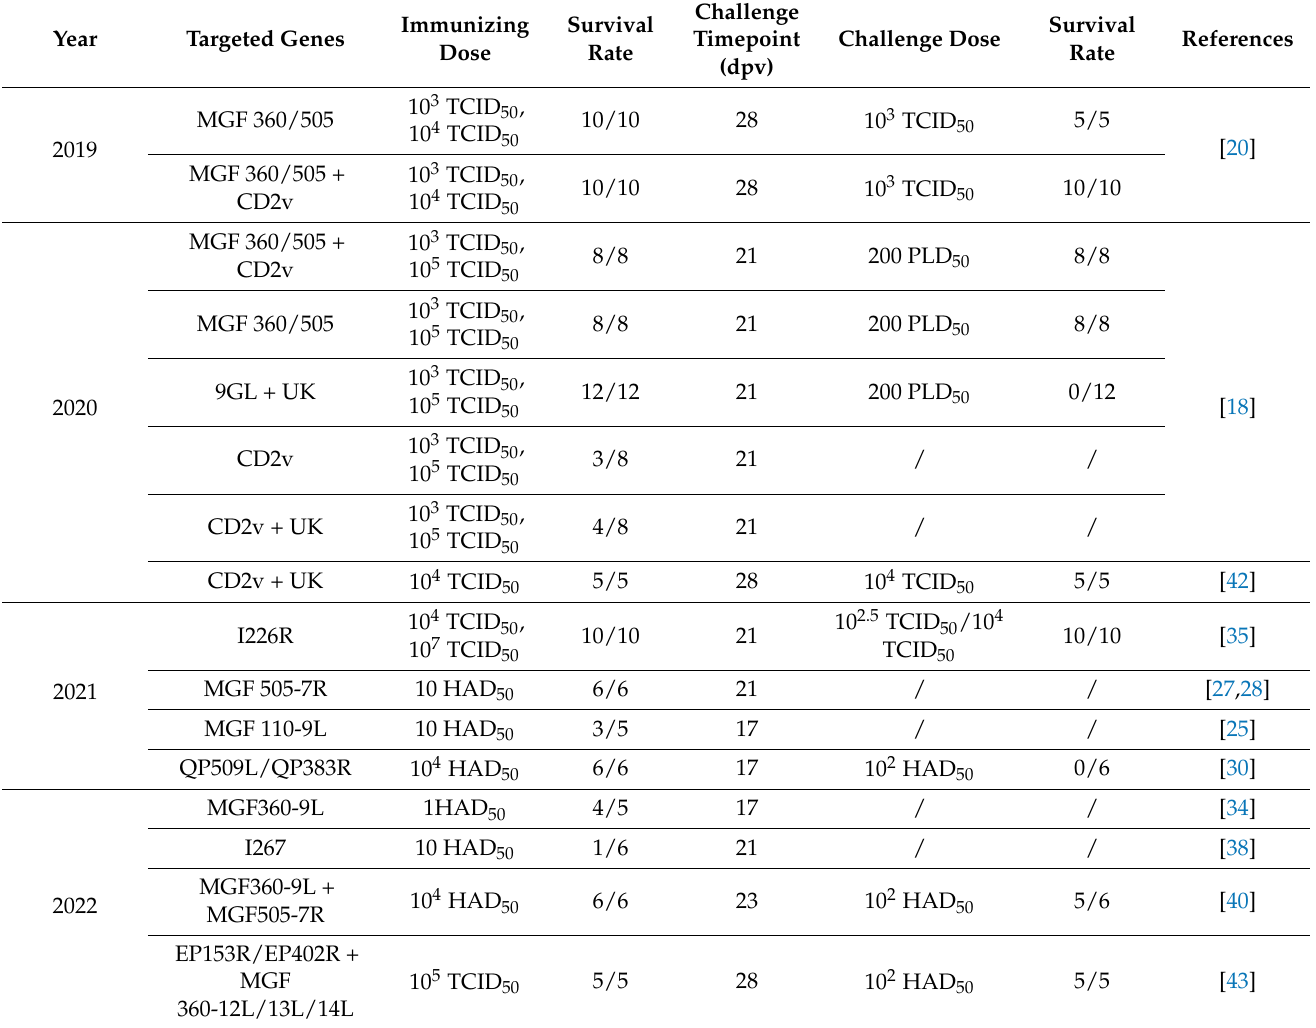
Table 2. Research progress of ASFV gene-deleted LAV candidate strains in China